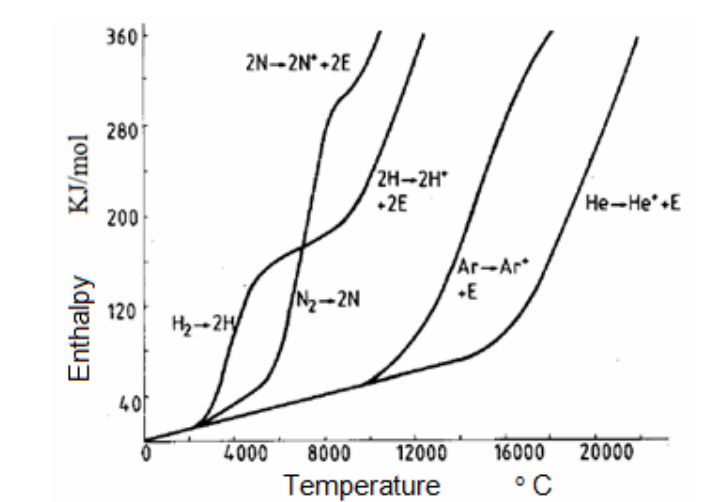
Figure 5 – Dependence of the enthalpy on the temperature of plasma gases (Gaji ć , et al., 1996, pp.448-451) Slika 5 – Zavisnost entalpije od tempetrature plazma gasova (Gaji ć , et al., 1996, pp.448-451) Рис . 5 – Зависимость энтальпии от температуры плазменных газов ( Гаич и др ., 1996, стр